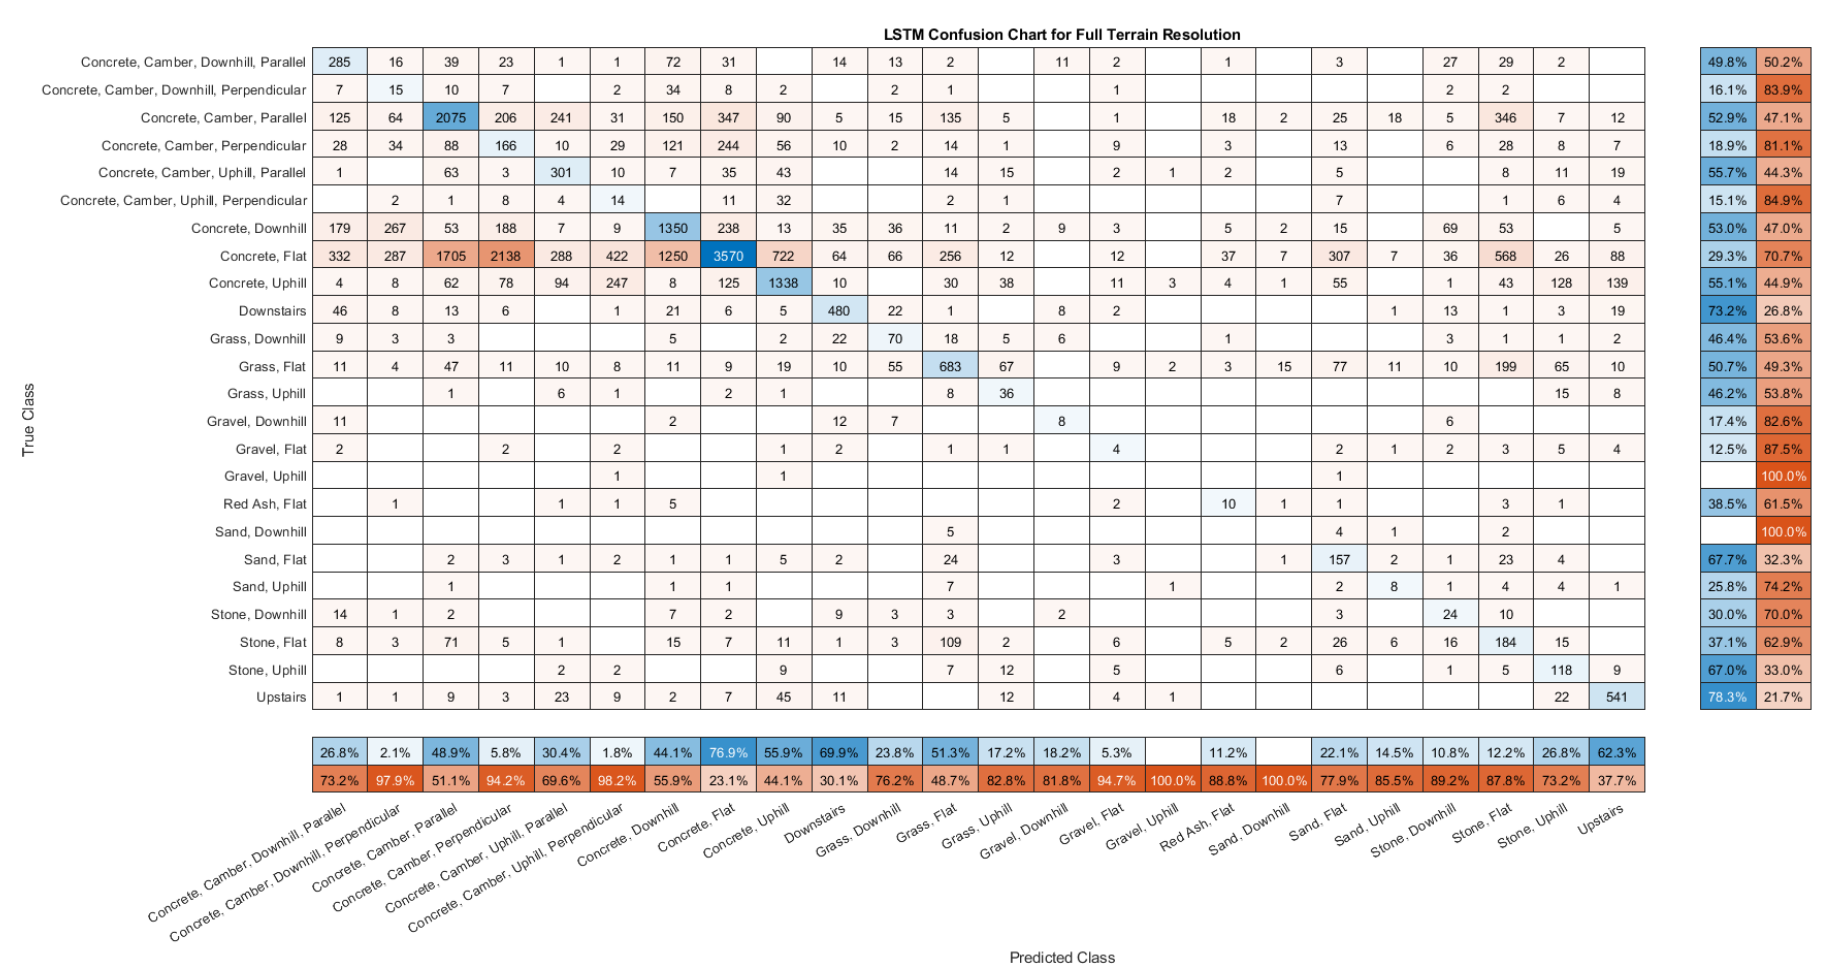
Figure A6. Long Short-Term Memory Network Confusion Chart for Level 3 label